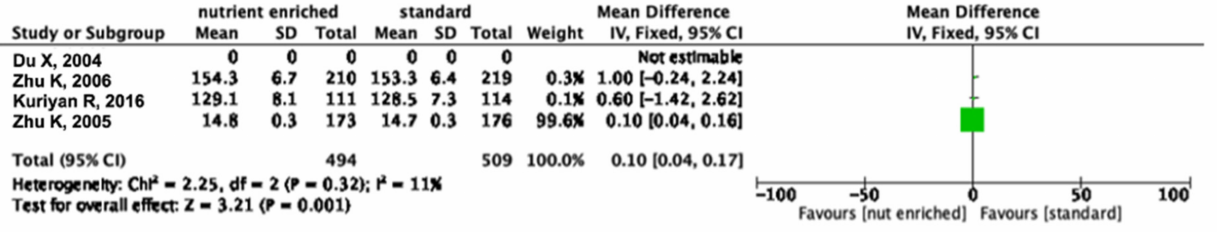
Figure 2. Meta-analysis of studies